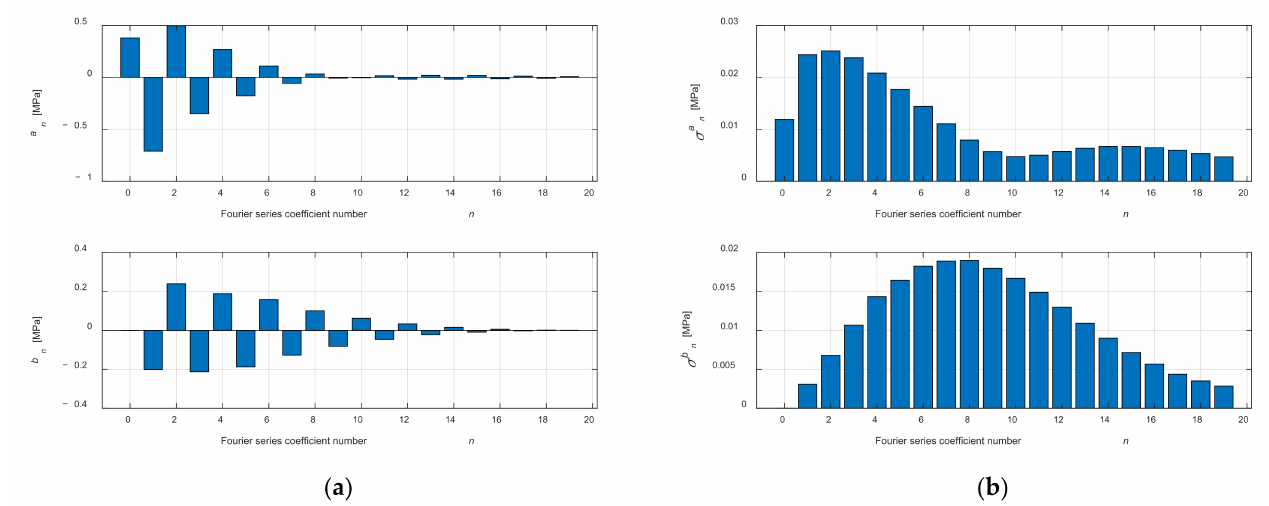
Figure 10. Determined coefficients a n and b n of a Fourier series after averaging ( a ) and determined values of standard deviations σ a n and σ b n ( b ) for 100 consecutive